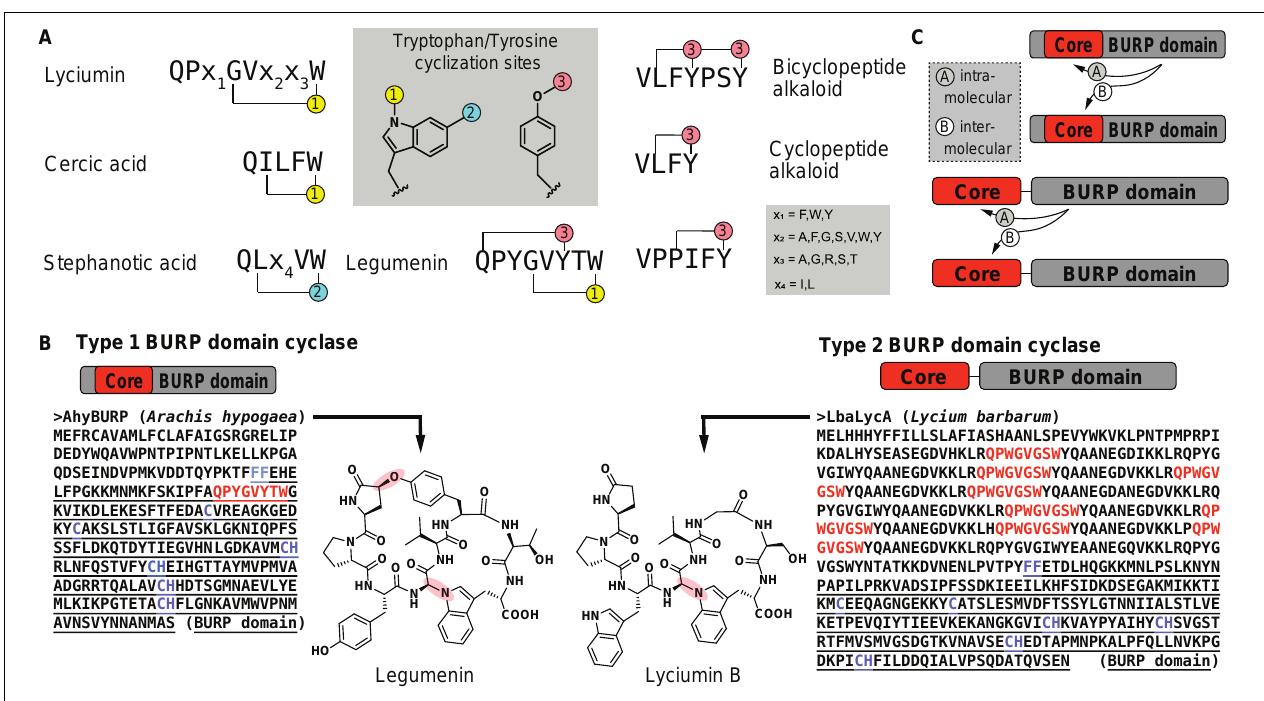
FIGURE 7 | Primary structure of BURP domain peptide cyclases. (A) Characterized core peptide substrate sequences of known BURP domain peptide cyclases and characterized tyrosine- or tryptophan-derived macrocyclization sites (1–3). (B) Primary structures of representatives of the two general types of BURP domain cyclases and corresponding peptide natural products. In the BURP domain sequence, core peptides corresponding to the natural product are highlighted in red, the BURP domain sequence is underlined, the BURP domain-defining residues are highlighted in blue. (C) Two models of autocatalysis for BURP domain-based peptide